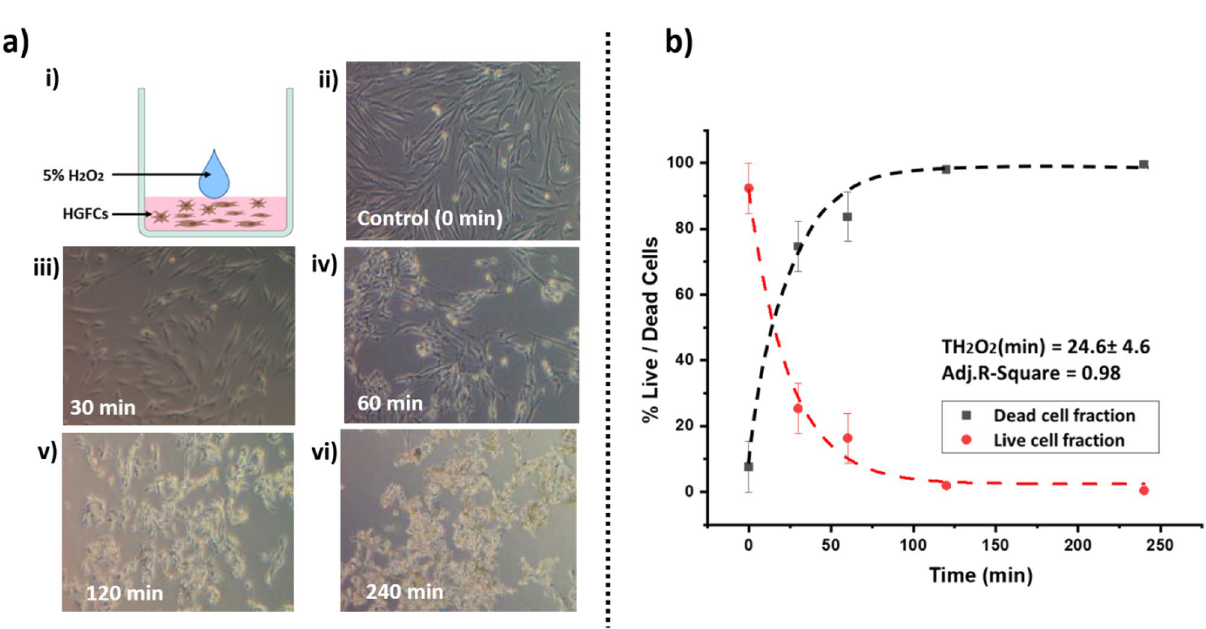
Figure 5. Impact of H 2 O 2 on human gingival fibroblast cells (HGFCs) viability. ( a ) Evaluation of HGFCs exposed to 5% H 2 O 2 . (i) Schematic depicting a cultured sample of HGFCs exposed directly to 5% H 2 O 2 solution. (ii, iii, iv, v & vi) Microscopic imaging showing the change in cell shape and morphology at different time points following exposure to H 2 O 2 . ( b ) Fitted plot showing the percentage of live/dead cells over time following the exposure of HGFCs to 5% H 2 O 2